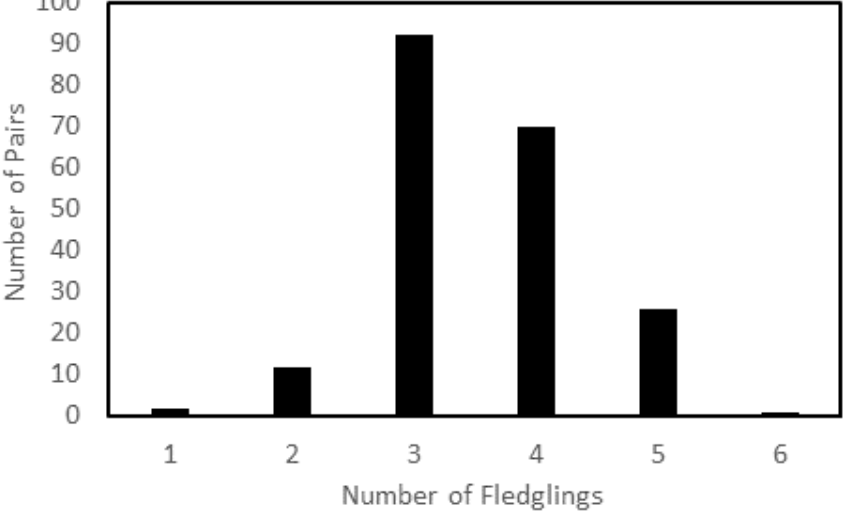
Figure 2. The number of fledglings of the eagle owl ( Bubo bubo ) during the years 2006–2010 in the Judea region of central Israel.